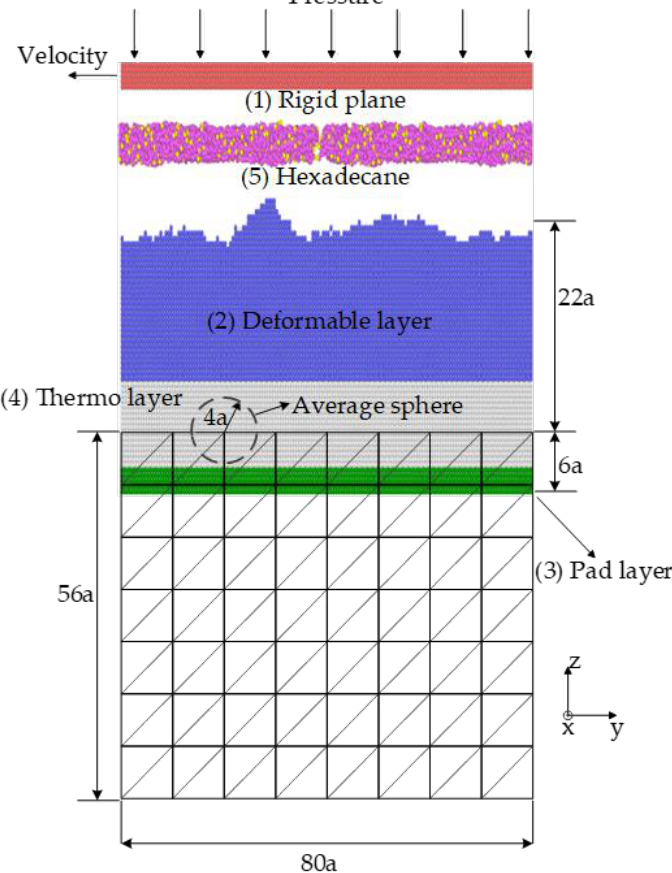
Figure 1. Schematicofthemodelset-up. a = Figure 1. Schematic of the model set-up. a = 0.4045 nm is the lattice constant of the single crystal aluminum.